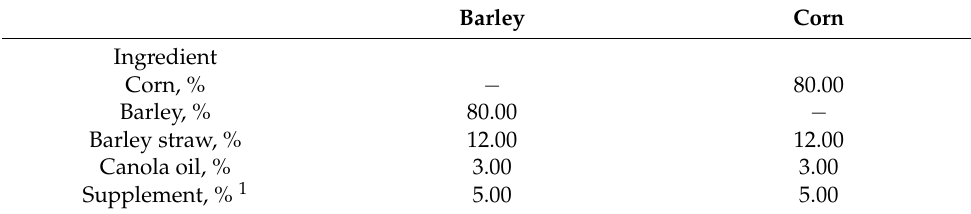
Table 1. Ingredient composition of finishing diets containing corn or Hockett barley as basal grains.